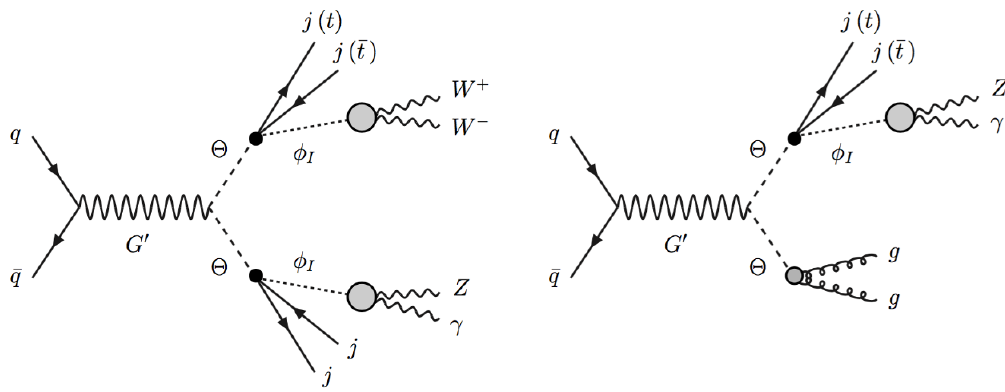
(cid:2) > M (cid:30) I when (cid:30) I